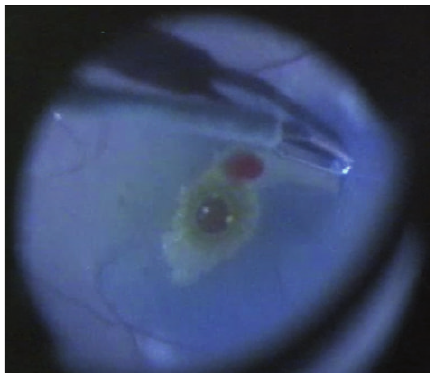
Figure 3: Internal limiting membrane peeling during right eye pars plana vitrectomy after brilliant blue staining. Note: edge of internal limiting membrane peeling (black arrow) and full thickness macular hole (white